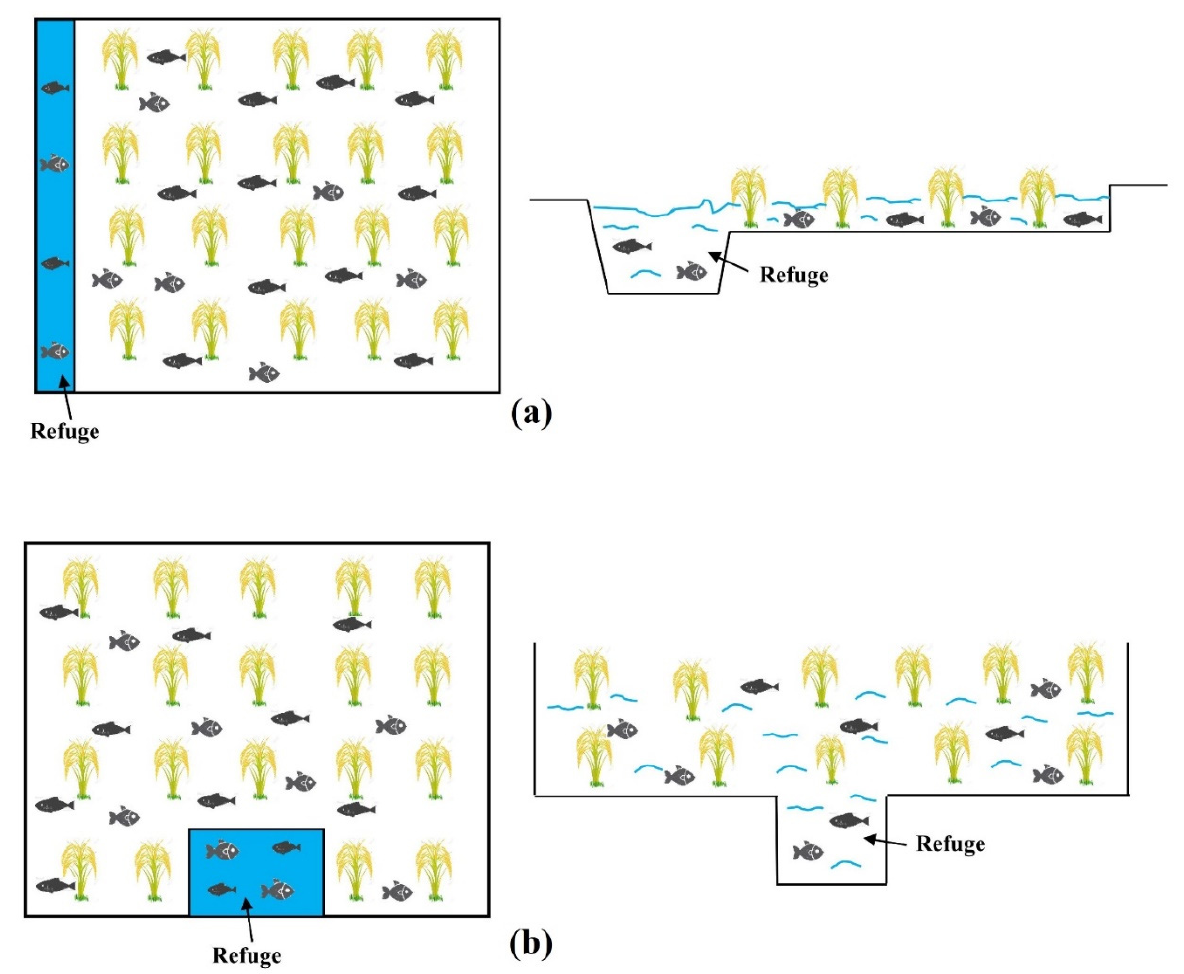
Figure 1. Rice–fish co-culture field type: ( a ) canal refuge and ( b ) pond refuge. Note: The refuges in our study sites were heterogeneous in size (depth and width).